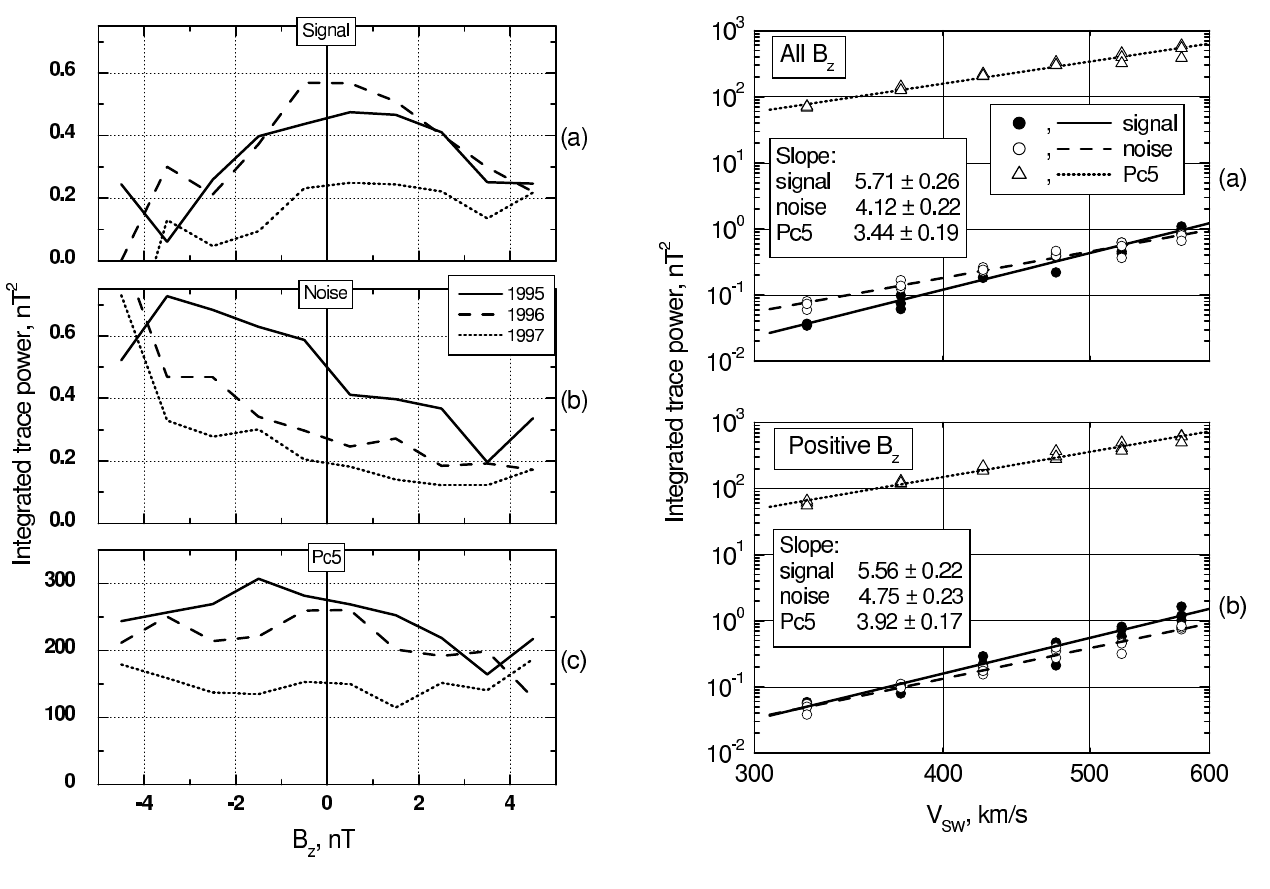
Fig. 10. Dependence of integrated trace power at Davis over 1995– 1997 on B z for (a) signal , (b) noise , and (c) Pc5 component.